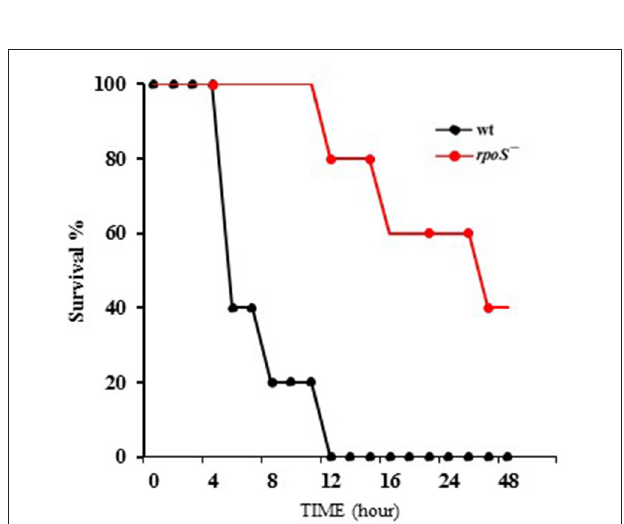
FIGURE 6 | Mouse lethality caused by V. vulnificus was decreased by an rpoS mutation. V. vulnificus wild-type or an rpoS mutant strains (1 × 10 7 CFU/mouse) were separately administered to 8 week-old CD-1 mice via the intraperitoneal route. Five mice were tested for each group, and the infected mice were observed for 48h.